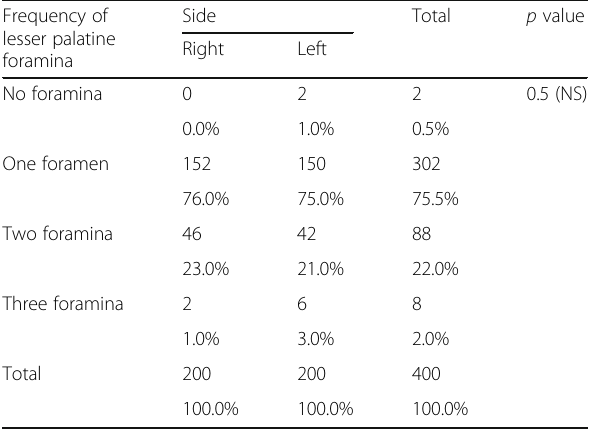
Table 3 Number, frequency, and percent of lesser palatine foramina